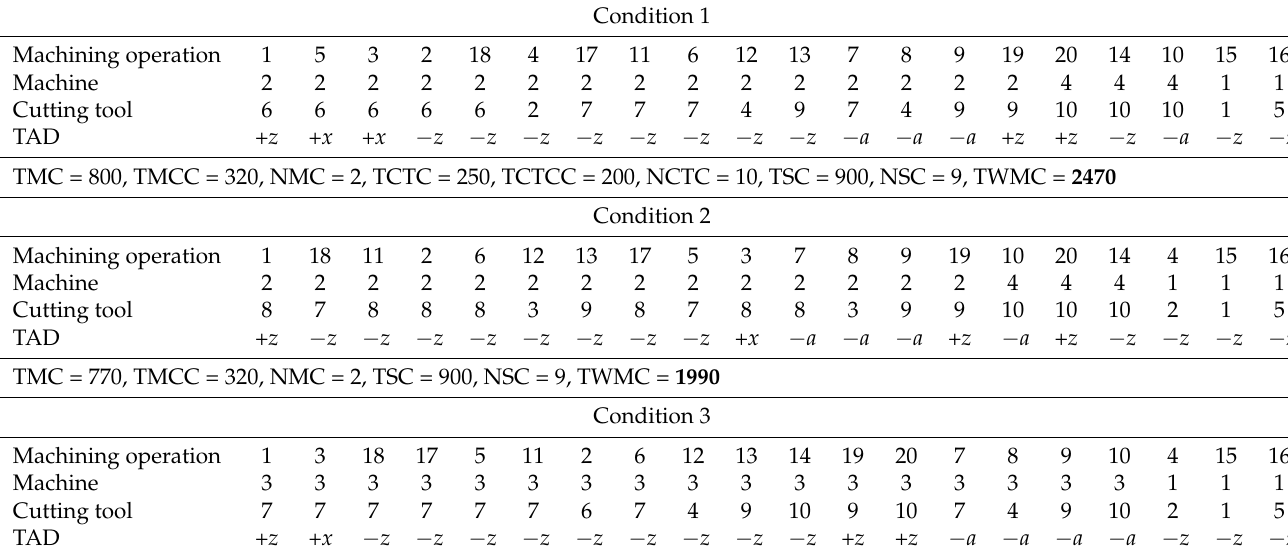
Table 8. Optimal process plans for prismatic part 1 and three optimization